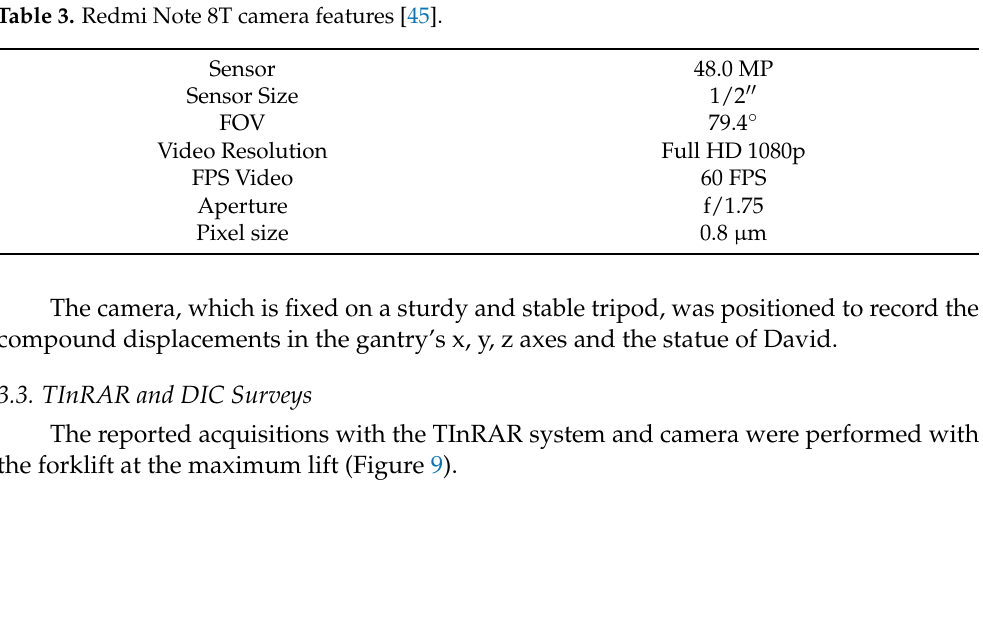
Table 3. Redmi Note 8T camera features [45].